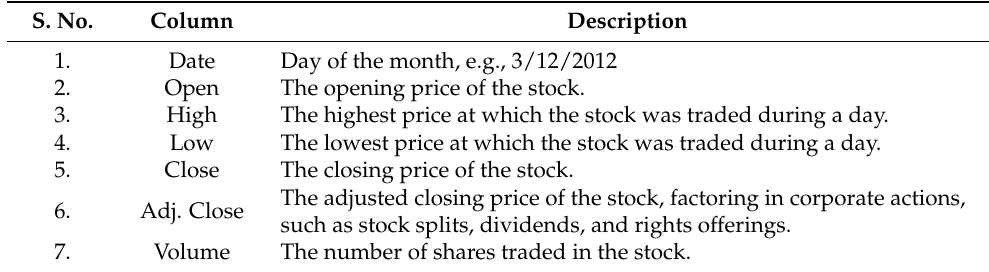
Table 2. Description of the historical stock